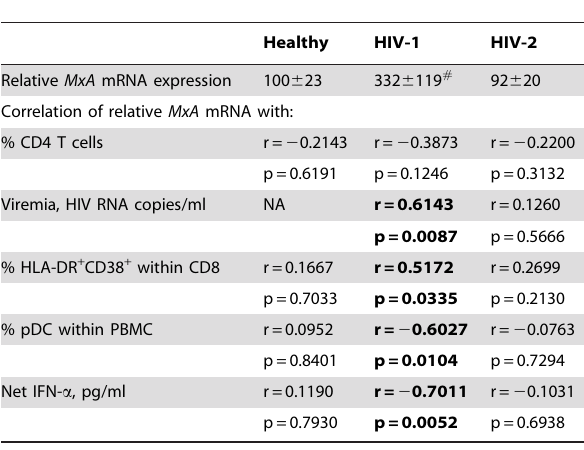
Table 2. Relative MxA mRNA